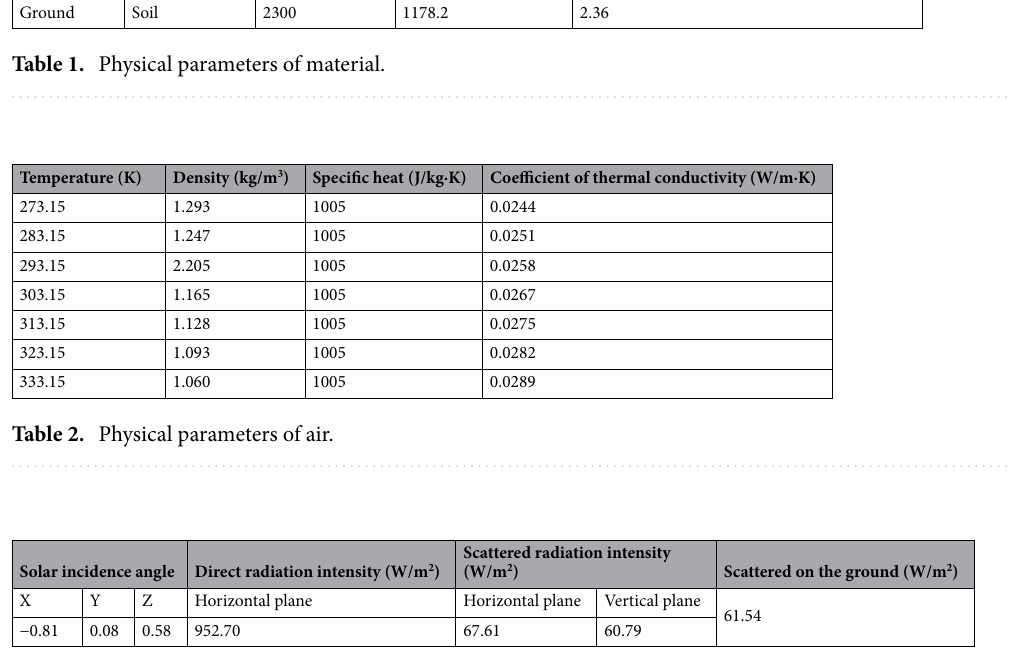
Table 3. Parameters of solar radiation.